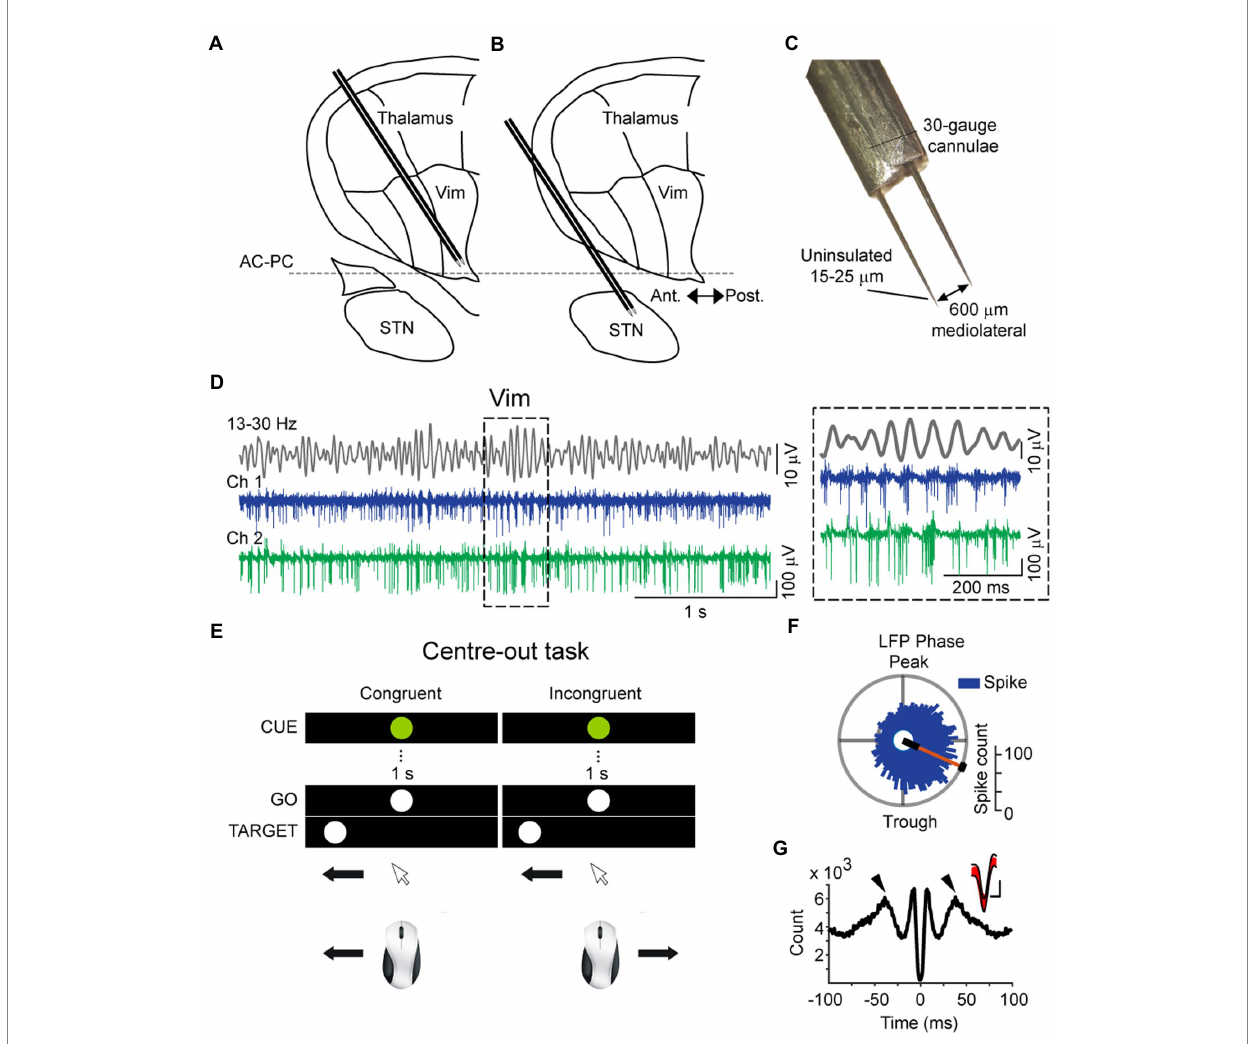
FIGURE 1 Schematic of intraoperative microelectrode recordings of the thalamus (A) and subthalamic nucleus (B) , superimposed on a sagittal Schaltenbrand and Wahren map, 14.5 mm from the midline. (C) Dimensions of dual microelectrodes used for intraoperative recordings, visualized in 10× magnification. (D) Recording traces of the cerebellar zone of the thalamus (ventral intermediate nucleus – Vim) obtained simultaneously from two microelectrodes (Ch1 and Ch 2) and the bandpassed signal from Ch1 (top, 13–30 Hz), showing the modulation of beta amplitude and corresponding spiking activity. Inset: example recordings showing the coupling of Vim multi-unit activity to the phase of the field beta oscillation. (E) Schematic of the center-out task conducted by patients during intraoperative microelectrode recordings. Patients were instructed to aim toward the peripheral target after a brief visual fixation in two conditions: “normal” orientation with congruent hand-eye orientation and incongruent (“inverted”) orientation. (F) Vim single-units were phase-locked to the rising phase of the LFP beta oscillation (Rayleigh Uniformity test, pRayleigh < 0.001). (G) Spike-triggered average of the Vim field potential, showing rhythmic peaks at the beta cycle (50 ms) and the rising phase of the field around the time of the spike. The large negative deflection at 0 ms is due to the averaged negative polarity of multi-unit activity. Inset: overlaid spike waveforms (red) and the confidence boundaries used during template matching in spike